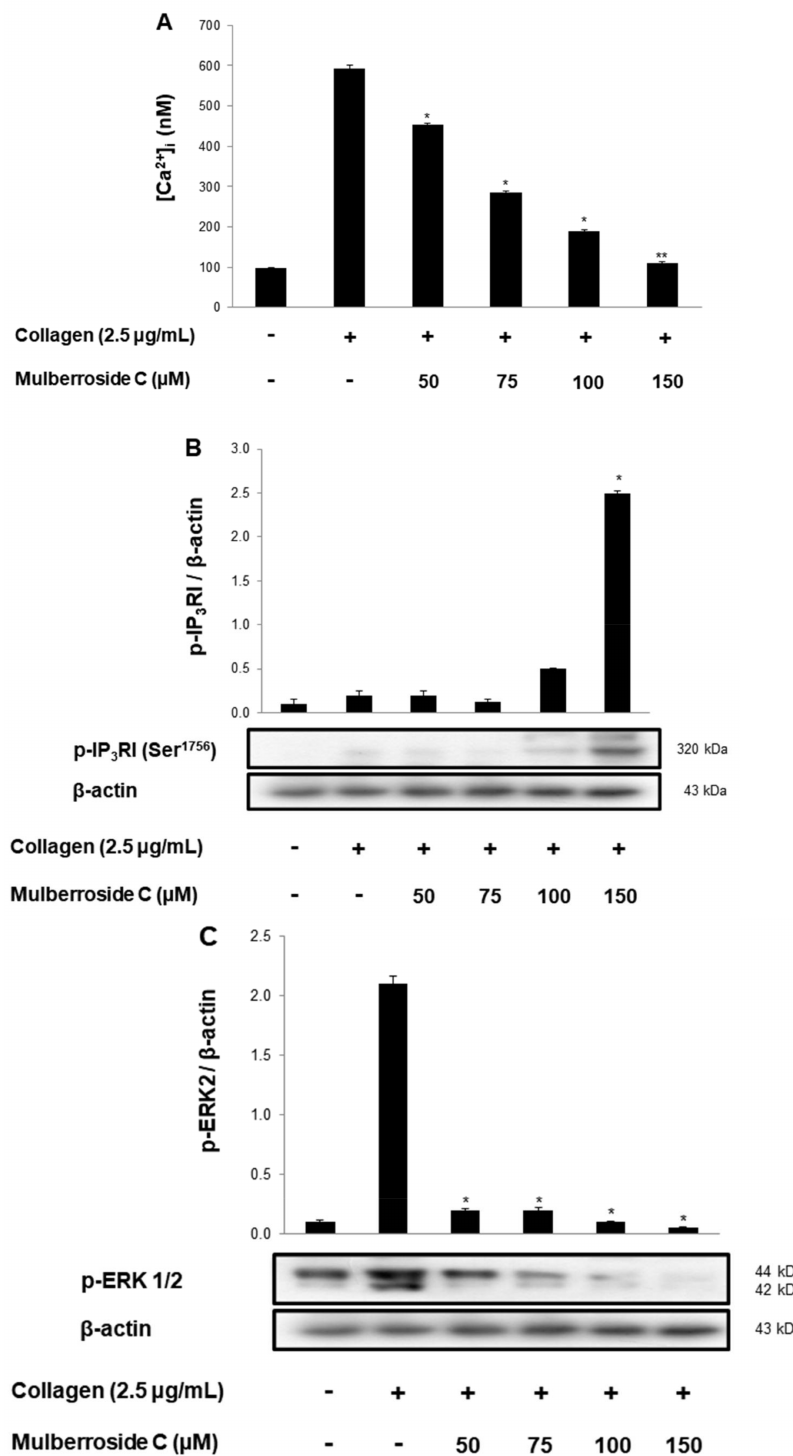
Figure 3. Effects of mulberroside C on Ca 2+ mobilization, IP 3 RI and ERK phosphorylation ( A ) Ef- fect of mulberroside C on collagen-induced Ca 2+ mobilization; ( B ) Effect of mulberroside C on collagen-induced IP 3 RI phosphorylation; ( C ) Effect of mulberroside C on collagen-induced ERK phosphorylation. Measurement of Ca 2+ mobilization, Western blot was performed as described in Section 2. The data are expressed as the mean ± standard deviation ( n = 4). * p < 0.05, ** p < 0.01 versus the collagen-stimulated human